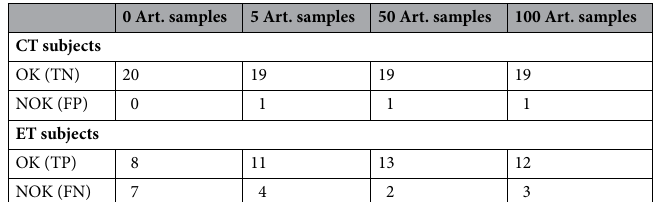
Table 2. Results (in terms of accuracy, sensitivity and specificity) of the diagnosis for each case, when using different number of artificial samples. Best cases are highlighted in bold.